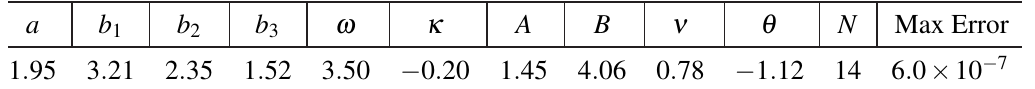
Table 4. Parameters for model (1) corresponding to example 4